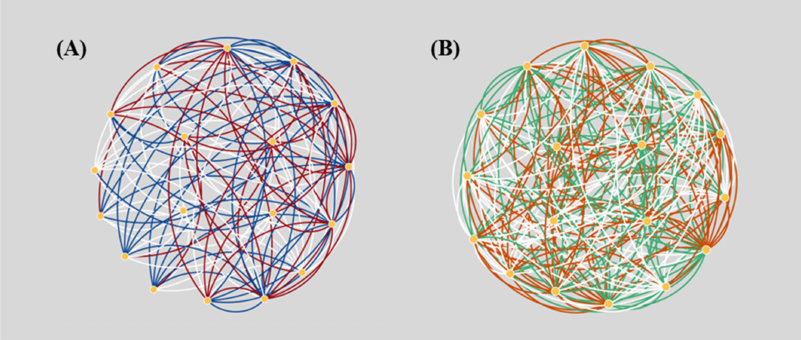
Figure 5. Schematic illustration of two superimposed PROPS ( A ) and BPA ( B ) randomly generated BNs of JAK-STAT-SOCS signaling. ( A ) Edges in red and blue represent those unique to the two PROPS-reconstructed BNs, respectively; ( B ) edges in orange and green represent those unique to the two BPA-reconstructed BNs, respectively. The low coincidence of the edges contained in the two networks can be observed, indicating the randomness of the BN structures by the two